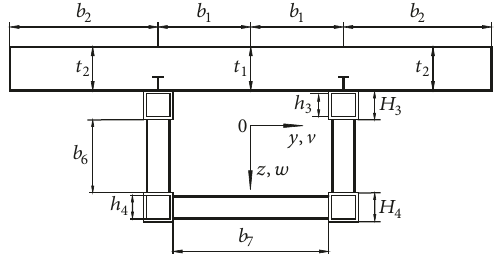
Figure 1: Sectional dimension and the coordinate system of the